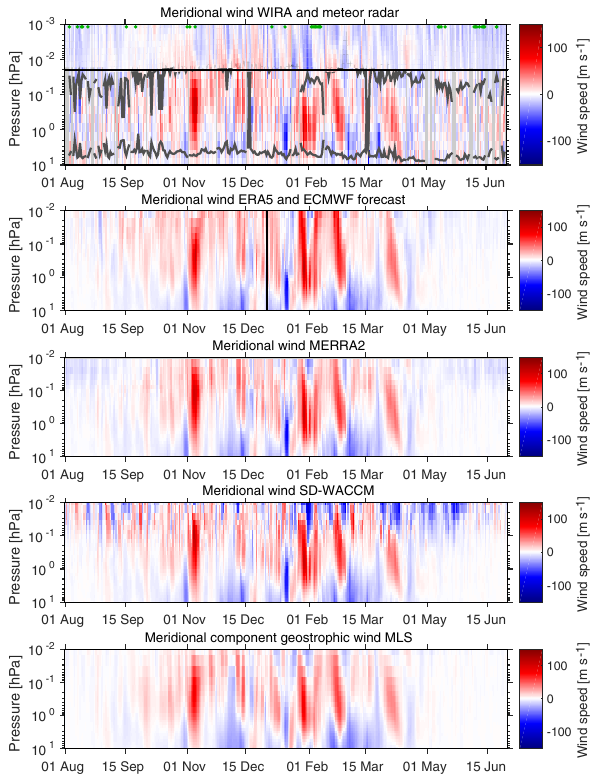
Figure 10. As Fig. 9 but for the meridional wind component.